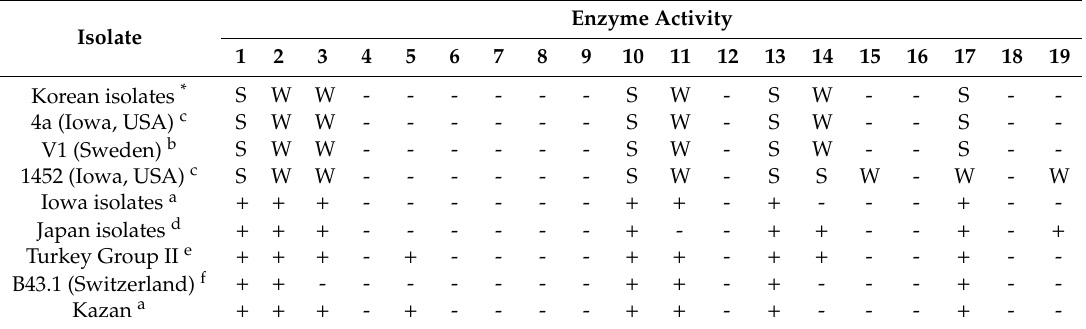
Figure 5. The unweighed paired group method with arithmetic mean (UPGMA) tree and heatmap based on average nucleotide identity (ANI) between T. phagedenis strain KS1 and other Treponema spp. Table 1. Enzyme activities of isolated Treponema phagedenis from bovine digital dermatitis lesions in South Korea as determined by API ®